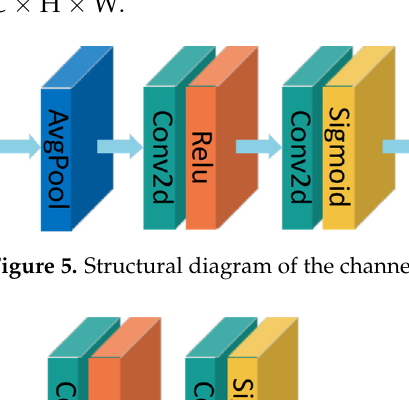
Figure 5. Structural diagram of the channel attention module.